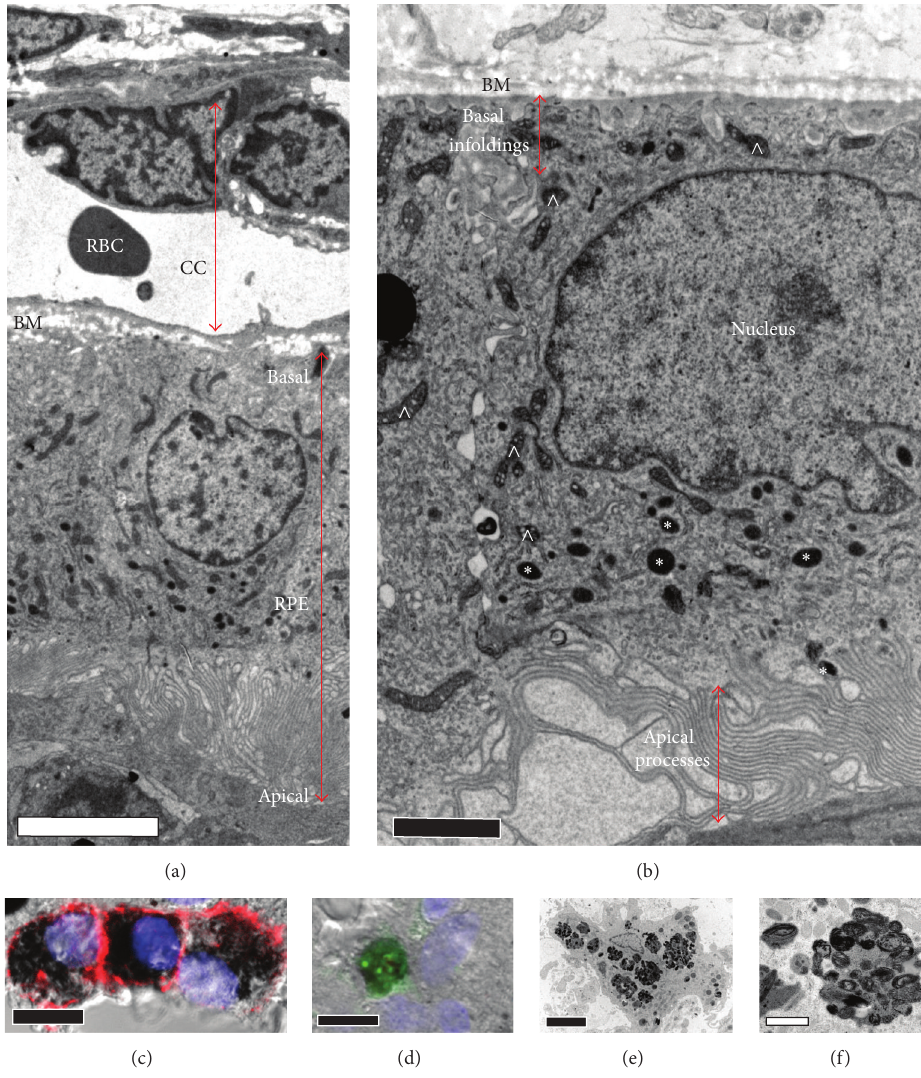
Figure 2: Cells with features characteristic of RPE are readily distinguishable in old RCS rats using ultrastructural examinations. (a and b) Ultrastructural RPE-like features are seen in electron micrographs. Just beneath the choriocapillaris (CC) lies Bruch’s membrane (BM). Basal infoldings, melanosomes (marked with “ ∗ ”s; not to be confused with electron dense mitochondria (marked with “ ∧ ”s)), and long apical processes seen in normal RPE cells are apparent. (c) Immunohistochemistry performed on paraffin embedded sections was performed with anti-Tra-I-85 (which recognizes human cells) and anti-Iba1 (which recognizes activated microglia) antibodies. Membranes of pigmented cells in the RPE domain of the RCS retina are Tra-I-85 positive (red) and Iba1 negative (green). (d) Other pigmented cells outside of the subretinal space are probably macrophages based on Tra-I-85 negative (red) and Iba1 positive (green) signatures. (e) An electron micrograph of a melanin-laden macrophage. (f) Melanin in the macrophages accumulated in very dense aggregates in the phagolysosomes compared with the pigment distribution in RPE cells (b). Images are representative; evidence of proper integration and some unintegrated RPE (especially around the injection site) were seen in all iPS-RPE injected eyes examined. Scale bars: (a) = 5 𝜇 m, (b) = 2 𝜇 m, (c) = 10 𝜇 m, (d) = 10 𝜇 m, (e) = 5 𝜇 m, and (f) = 1 𝜇